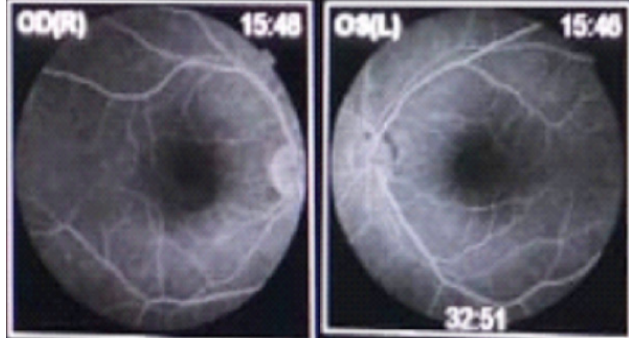
Figs 3a and 3b: Fundus fluorescence